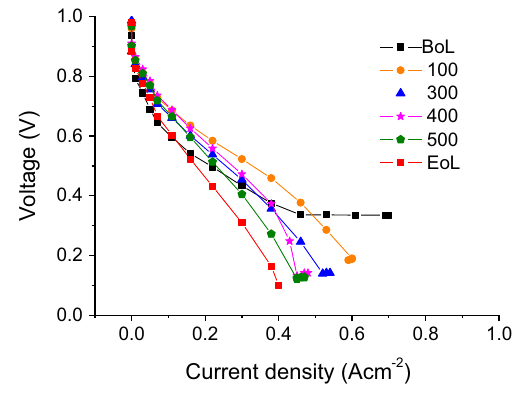
Fig. 5 The IV curves of the fuel cell prior to and after the SU/SD cycling test at 60 °C, 100% RH and 1.8/2.5 anode/cathode stoichiom- etry